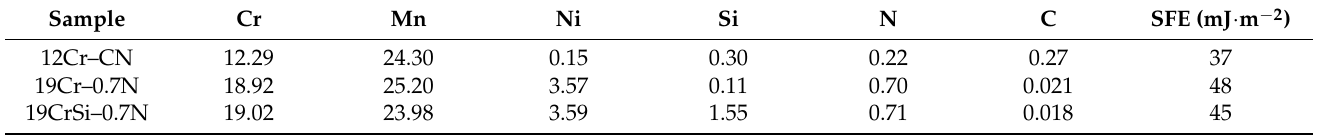
Table 2. Measured composition (mass %) of the main alloying elements of the investigated